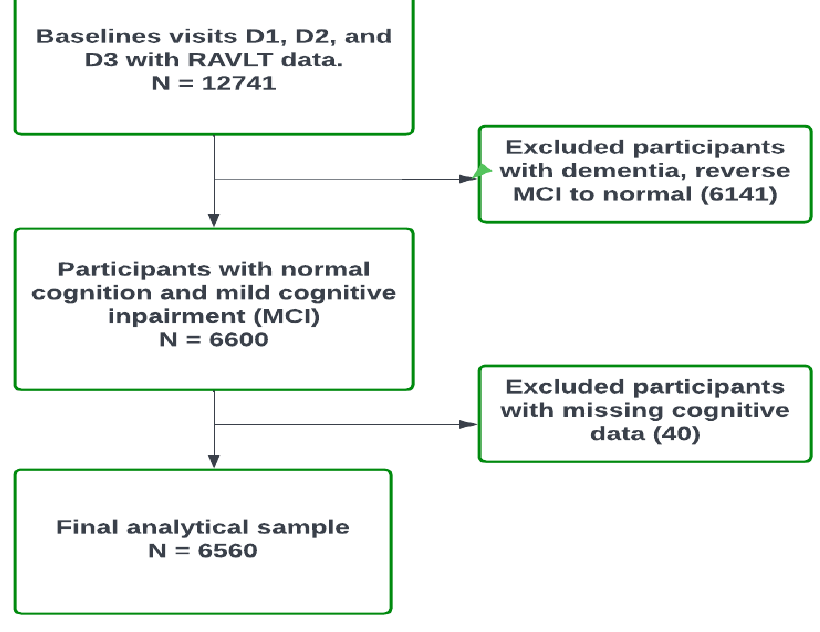
Figure 1. Diagram of analytical